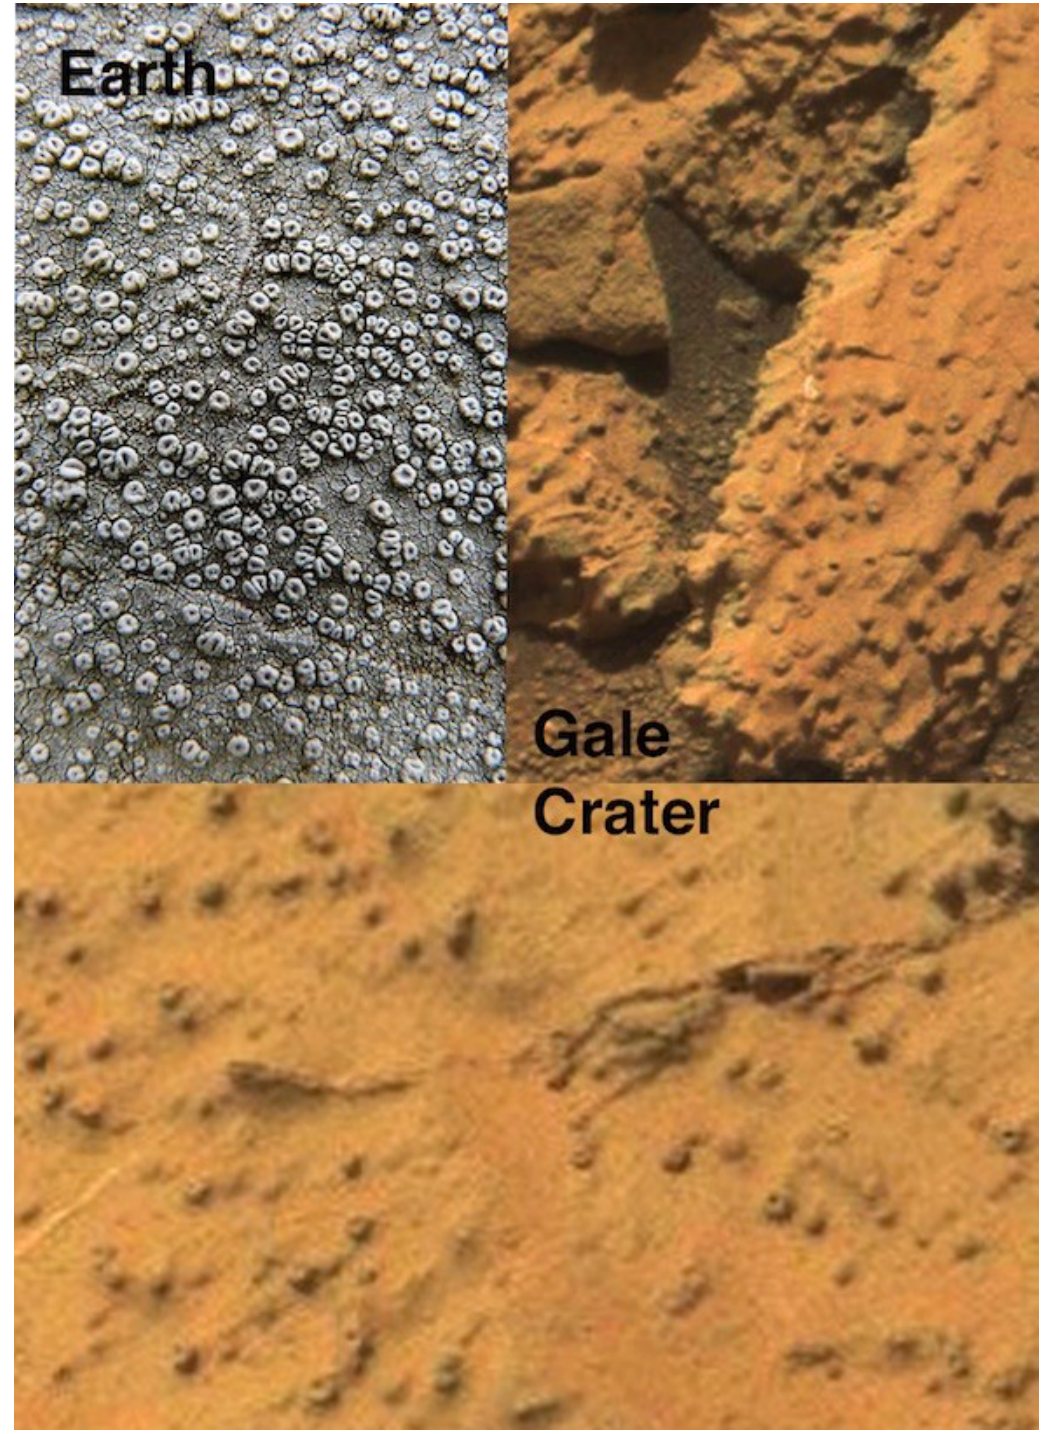
Figure 11. (Top Left): Earth. Lichens growing on the west coast Ireland cliffs of Moher (Photographed by Dr Jessica M Winder, https: //natureinfocus.blog. Reproduced with permission). (Top right and bottom) Gale Crater Sol 298: Specimens resembling dimpled lichens with what may be hyphae along the surface/subsurface. Note hollow apertures in the upper right corner and lower center of photo, and which resembles an oxygen-gas vents typically produced by photosynthesizing